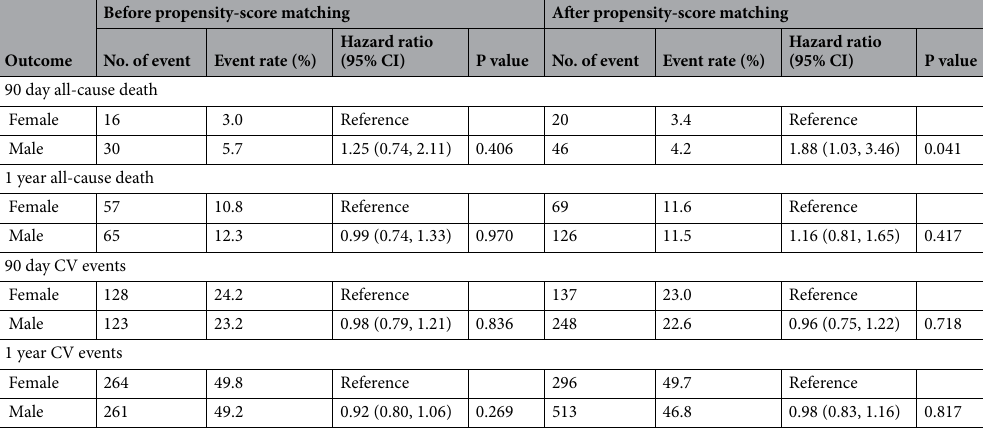
Table 3. Risk of primary and secondary outcomes before and after propensity-score-matched cohort. The propensity-score-matched cohort included 530 patients in the male group and 530 patients in the female